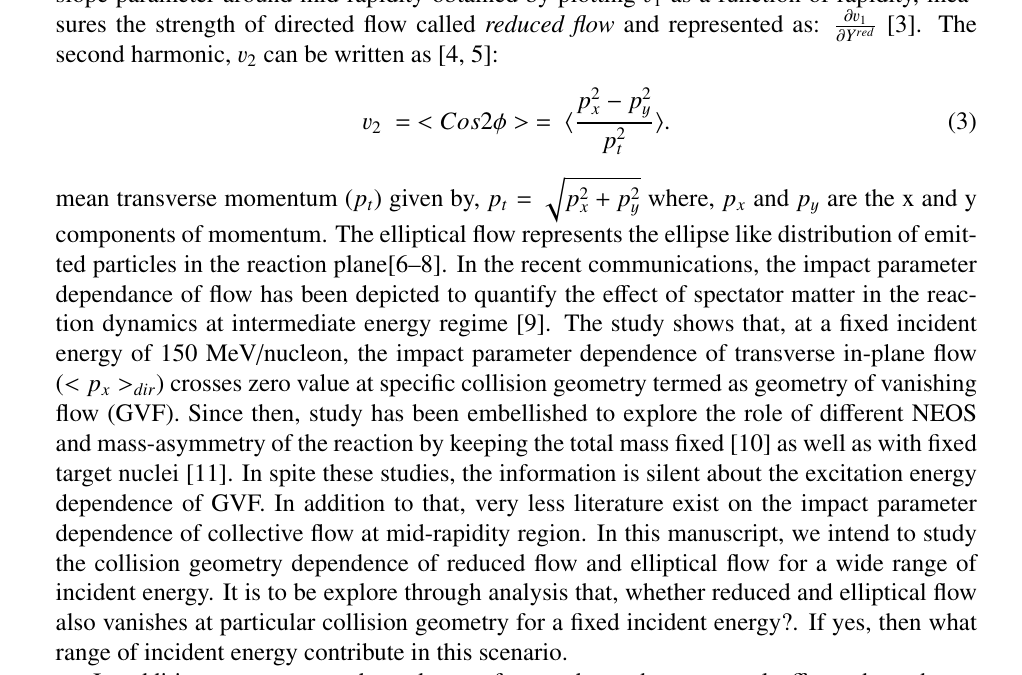
Fig. 1 display the scaled impact parameter dependence of reduced flow for the reactions of 50 Ca + 50 Ca (upper panels) and 197 20 20